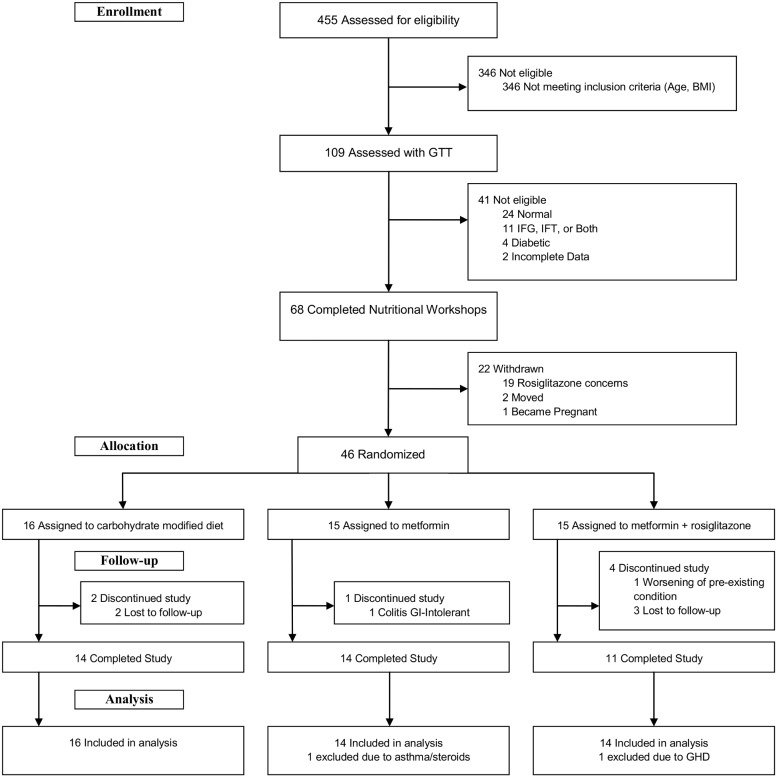
CONSORT Diagram.